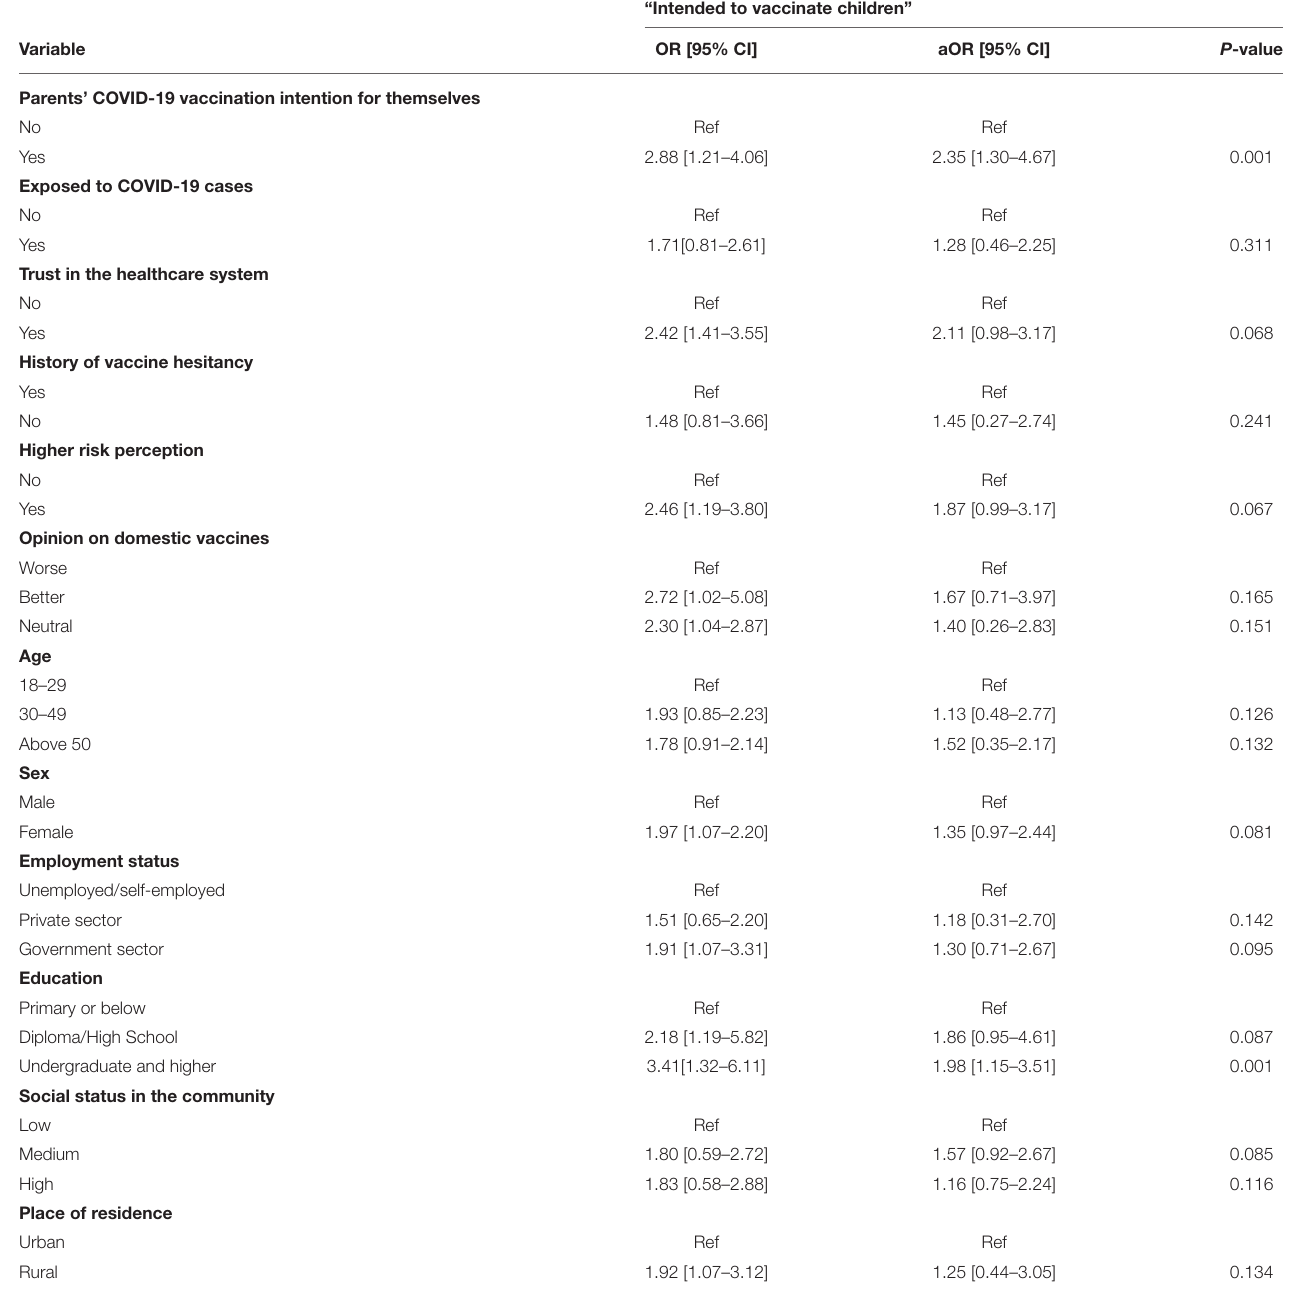
“Intended to vaccinate